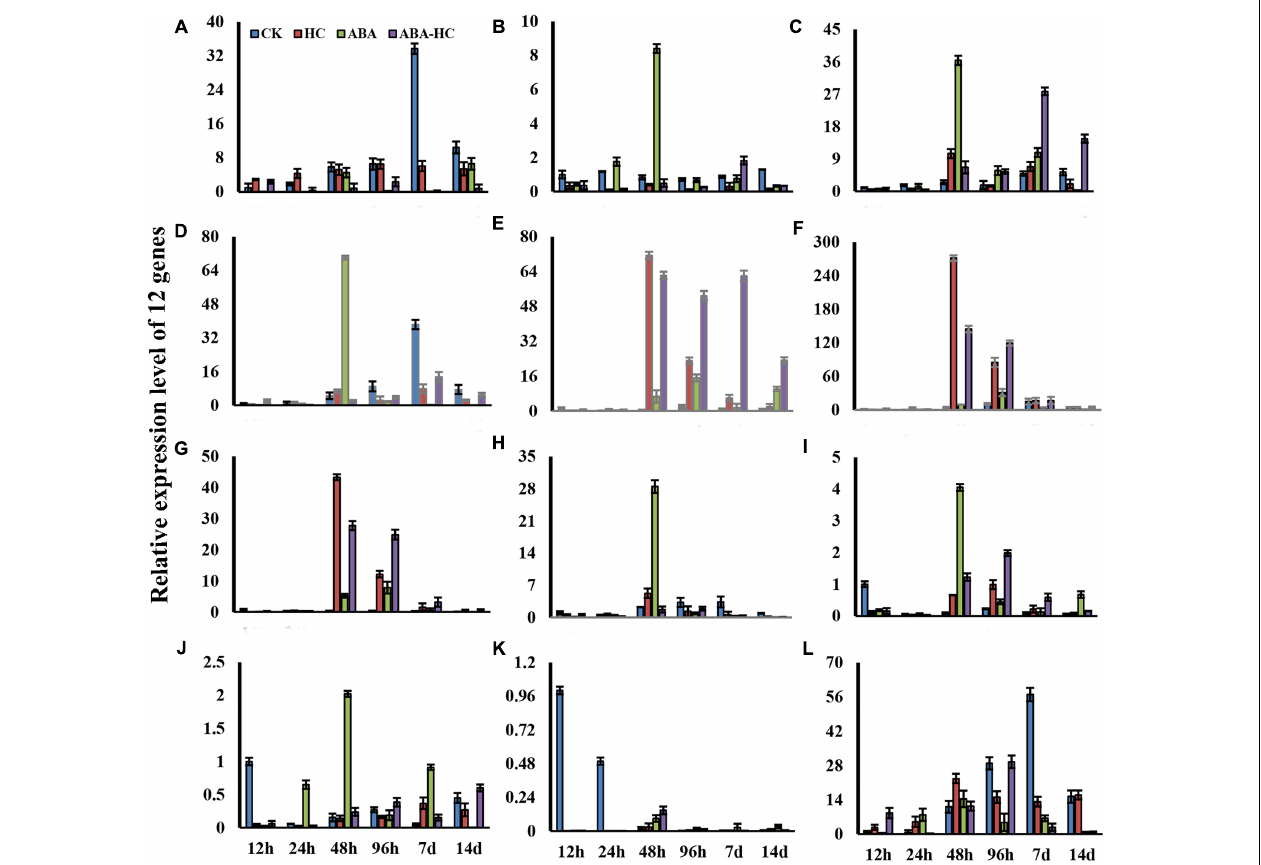
FIGURE 6 | Relative Expression level of 12 genes (A) . Gene ID: LOC100245705, Gene name: probable glutathione peroxidase (B) . Gene ID: LOC100262354, Gene name: probable fructose-bisphosphate aldolase 1, chloroplastic-like (C) . Gene ID: LOC100249258, Gene name: peroxidase 46 (D) . Gene ID: LOC100259748, Gene name: 2-Cys peroxiredoxin 2-Cys peroxiredoxin (E) Gene ID: LOC100255710, Gene name; probable carboxylesterase 8 (F) Gene ID: LOC100260853, Gene name: probable carboxylesterase 8 (G) Gene ID: LOC100244514, Gene name: transcription factor bHLH35 (H) Gene ID: LOC100264830: Gene name: transcription factor UNE12 (I) Gene ID: LOC100233013, Gene name: L -ascorbate peroxidase 2, cytosolic (J) Gene ID: LOC100262779, Gene name: protein TIFY 8 (K) Gene ID: LOC100254174, Gene name; probable protein phosphatase 2C 14 (L) Gene ID: LOC100253351, Gene name, protein kinase and PP2C-like